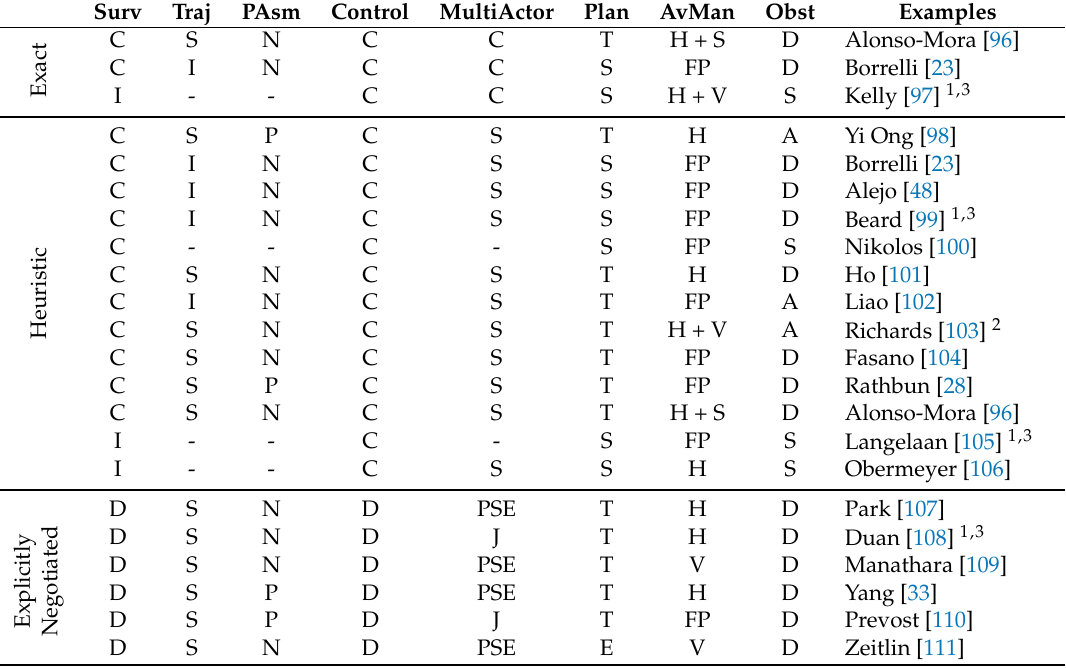
Table 4. Conflict detection and resolution methods for unmanned aviation. Table 5 defines the used